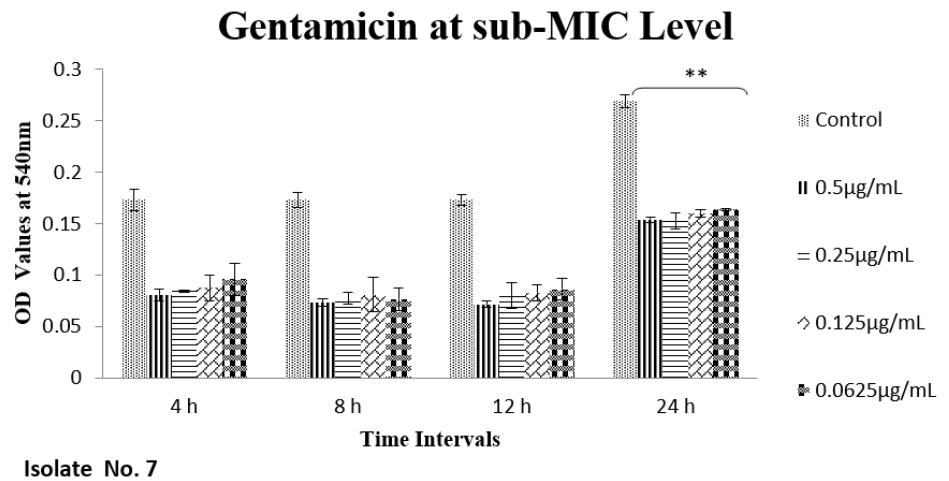
Figure 1. Shown are the effects of gentamicin on E. coli biofilms (OD 540 nm). Bar graphs showing significant reduction (** p value < 0.01) in biofilm formation at different time points when compared with the control samples.